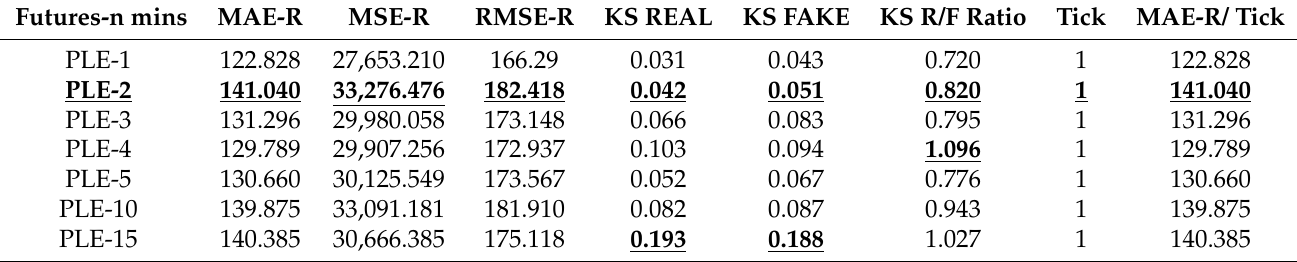
Table 7. PLE-n mins (platinum) represent futures contracts listed on CME at one, two, three, four, five, ten and fifteen minute intervals. Platinum futures have the highest MAE-R among all futures contracts. For KS R/F Ratio, two out of seven are bigger than one, where the highest KS REAL and FAKE are 0.193 and 0.188.